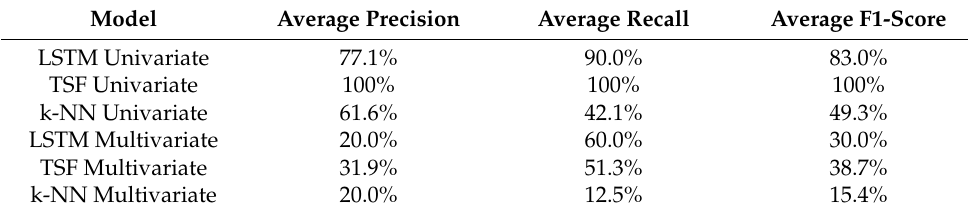
Table 16. Performance Parameters for Jamming Classification.